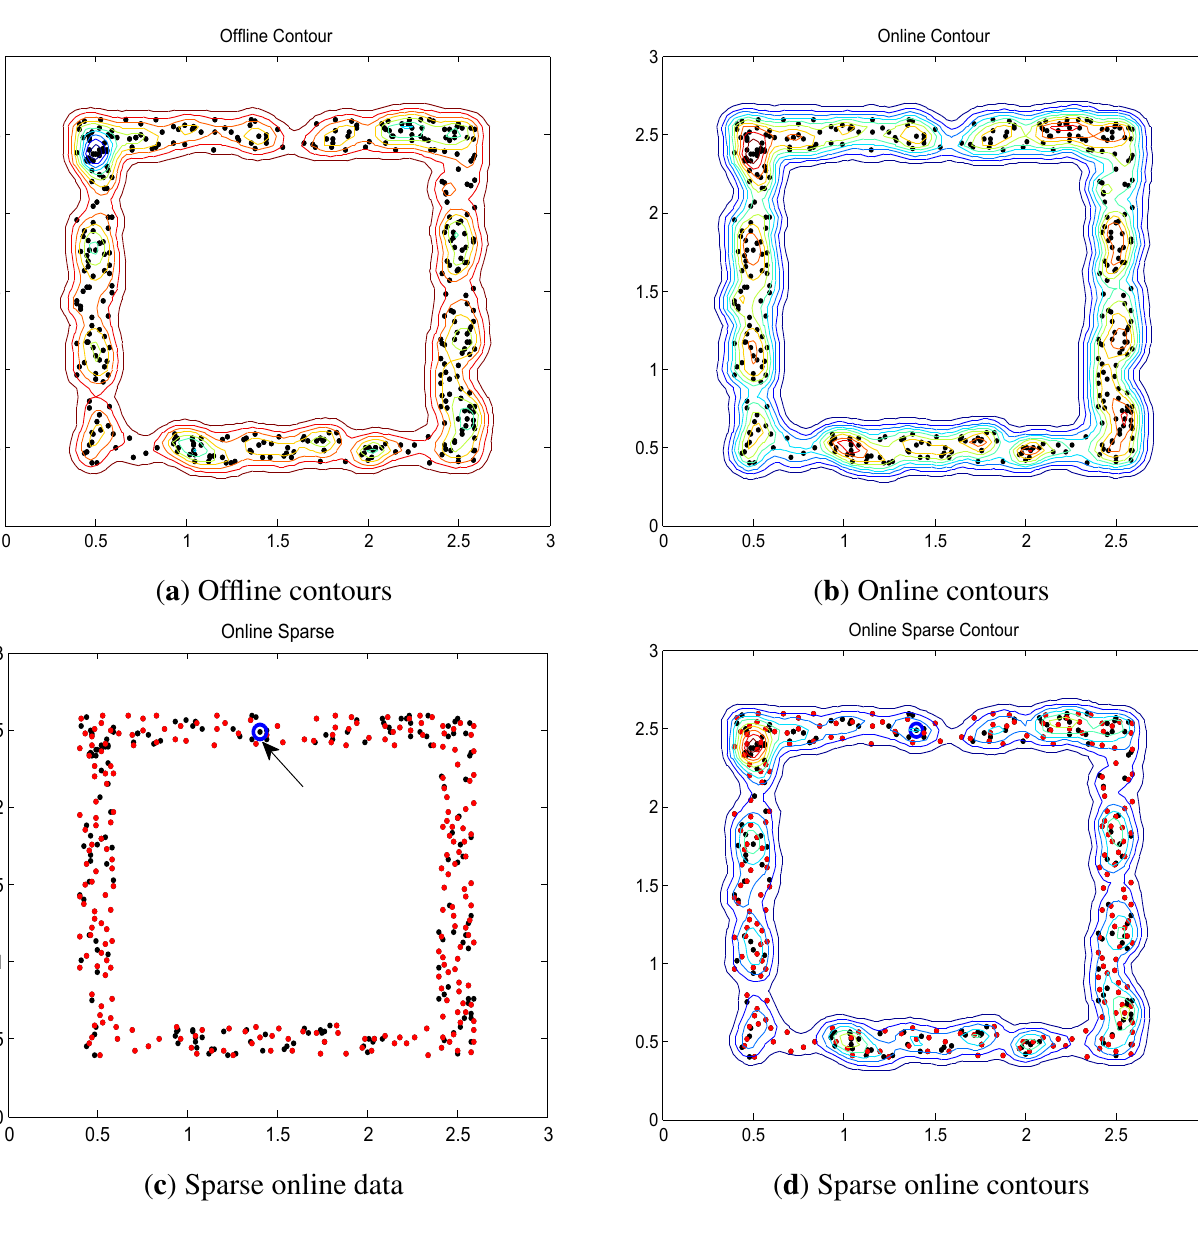
Figure 5. Offline, online LS-OC-SVM and sparse online LS-OC-SVM results of “square”. The figures might be viewed better electronically, in color and enlarged. ( a ) The contours when all the training data are learned as one batch offline; ( b ) The contours when the training data are learned via online LS-OC-SVM; ( c ) The blue circle (pointed out by the arrow) shows the original dictionary. The red points show the 232 new data included into the dictionary via sparse online LS-OC-SVM; ( d ) The contours when the training data are learned via sparse online